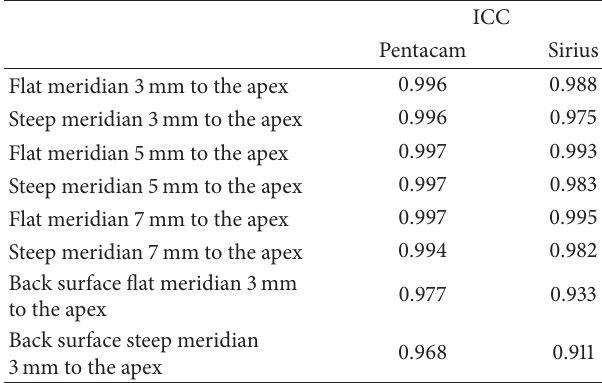
Table 3: Intraobserver variability of keratometry in healthy corneas (ICC = intraclass correlation